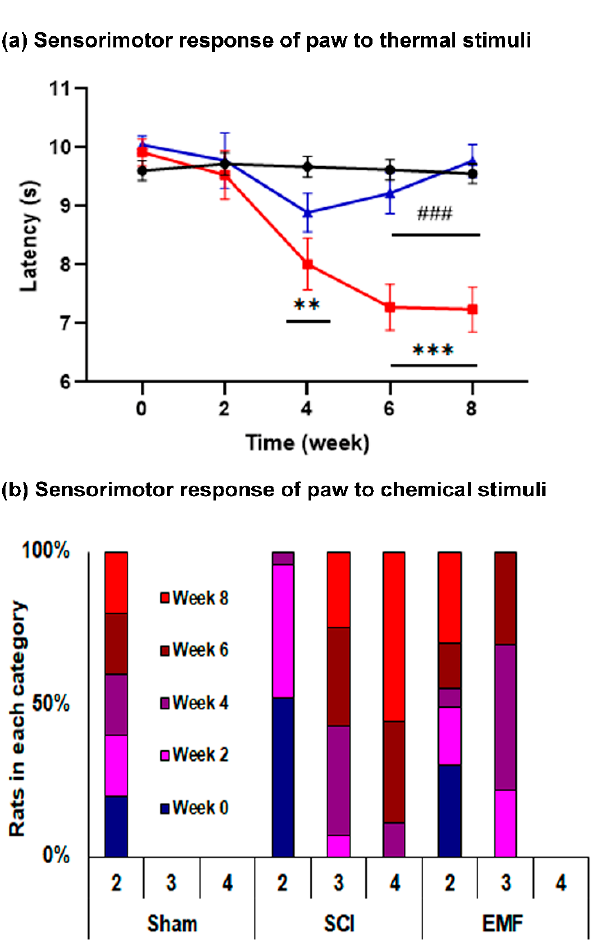
Figure 3. Effect of EMF stimulation on nociceptive responses of paws to thermal ( a ) and chemical stimuli ( b ) in the Sham (black line, n = 15), SCI (red line, n = 12), and EMF (blue line, n = 14) groups of rats. * indicates a comparison between Sham and SCI/EMF groups, while # indicates a comparison between SCI and EMF groups. ** p < 0.01 and ***/ ### p < 0.001.